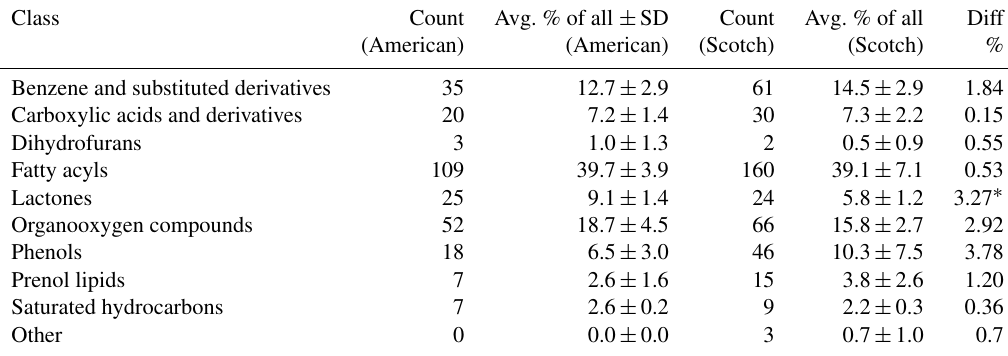
Table 2. Substance groups found in two different types of whisky (American/Scotch). Numbers show total counts of compounds within substance groups and the overall average proportion of substance groups (avg. % ± SD). Class denominations were taken as assigned in ClassyFire by Djoumbou Feunang et al.